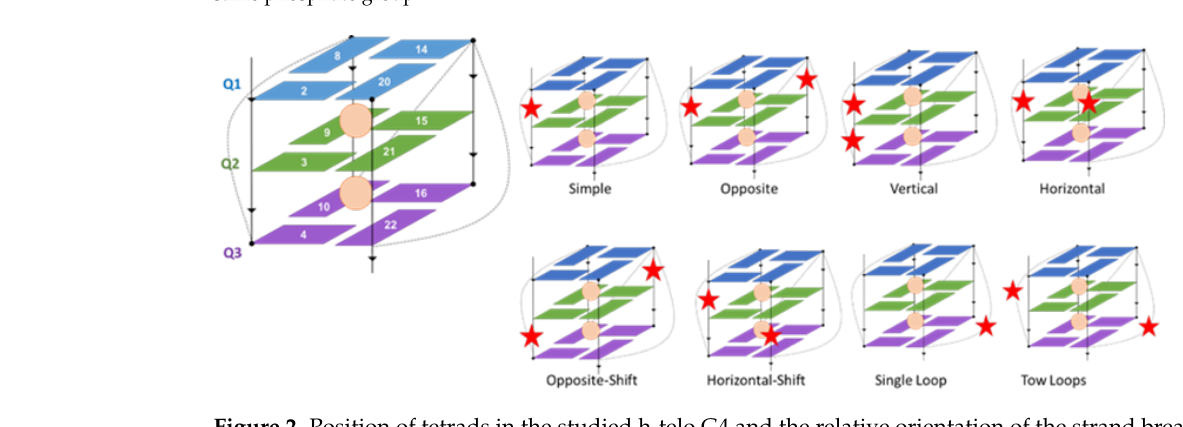
Figure 2. Position of tetrads in the studied h-telo G4 and the relative orientation of the strand break damage (displayed as red stars) in peripheral loops or the tetrad-connecting backbone. The orange dots represent cations. Table 1. Schematic representation of the positions of the considered strand breaks. as indicated by the symbol ★ . CA and NC strand breaks occur on the two O-P(O2)-O sides of the same phosphate group.